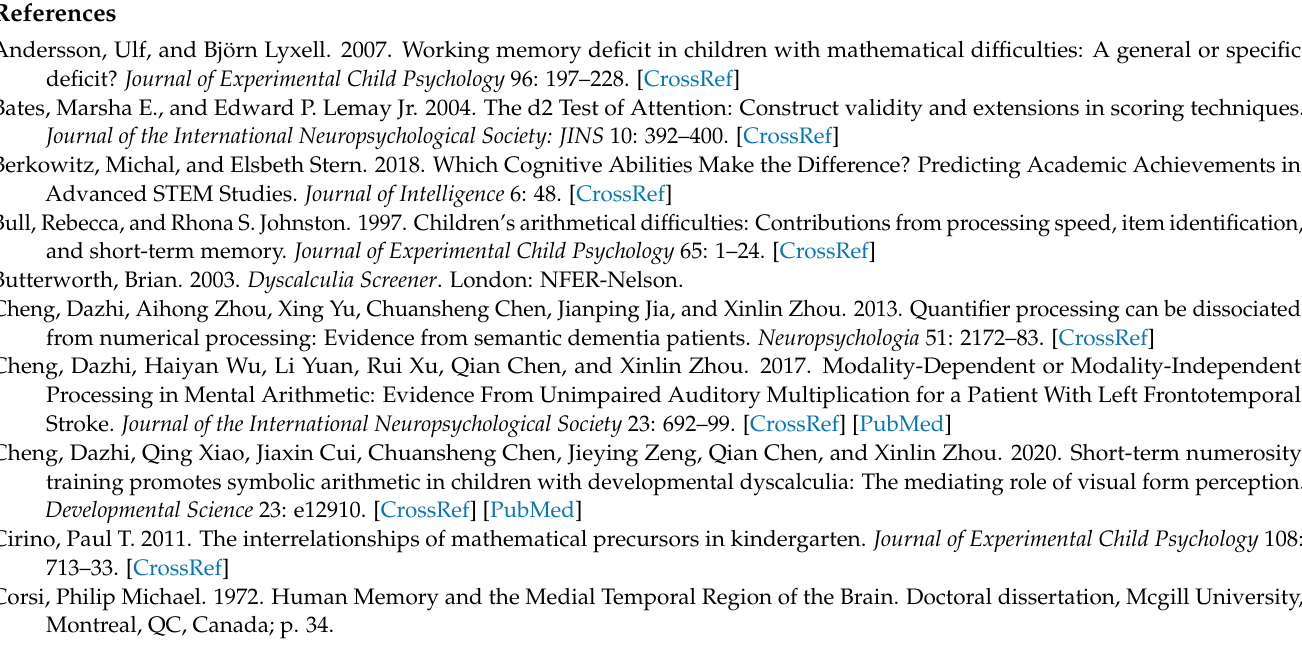
(Choice reaction time), Table S8. Hierarchical regression models predicting academic achievement in Grades 9 of junior high school considering age, gender, cognitive tests, general processing speed (Figure matching), Table S9. Hierarchical regression models predicting academic achievement in Grades 9 of junior high school considering age, gender, cognitive tests, specific processing speed (Word semantics), Table S10. Hierarchical regression models predicting academic achievement in Grades 9 of junior high school considering age, gender, cognitive tests, specific processing speed (Simple subtraction). Table S11. Hierarchical regression models predicting academic achievement in Grades 9 of junior high school considering age, gender, cognitive tests, specific processing speed (Complex subtraction). Table S12. Hierarchical regression models predicting academic achievement in Grades 9 of junior high school considering age, gender, cognitive tests, specific processing speed (Complex